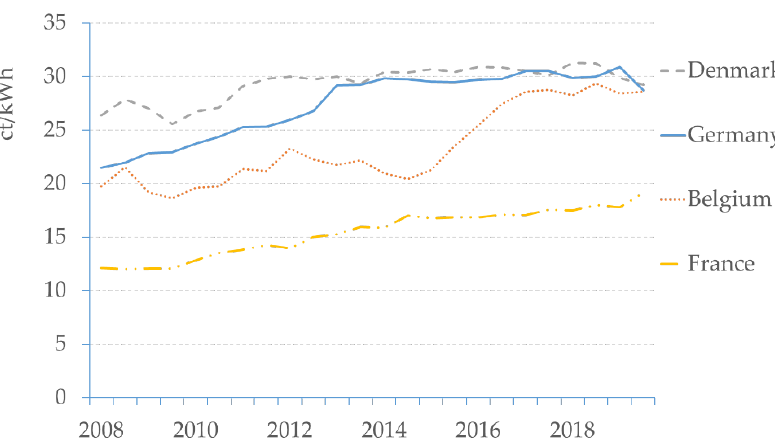
Figure 1. Electricity price development when sold to private households (annual consumption of 2500 kWh to less than 5000 kWh), first half-year 2008 to second half-year 2019, comparing selected EU countries [3].